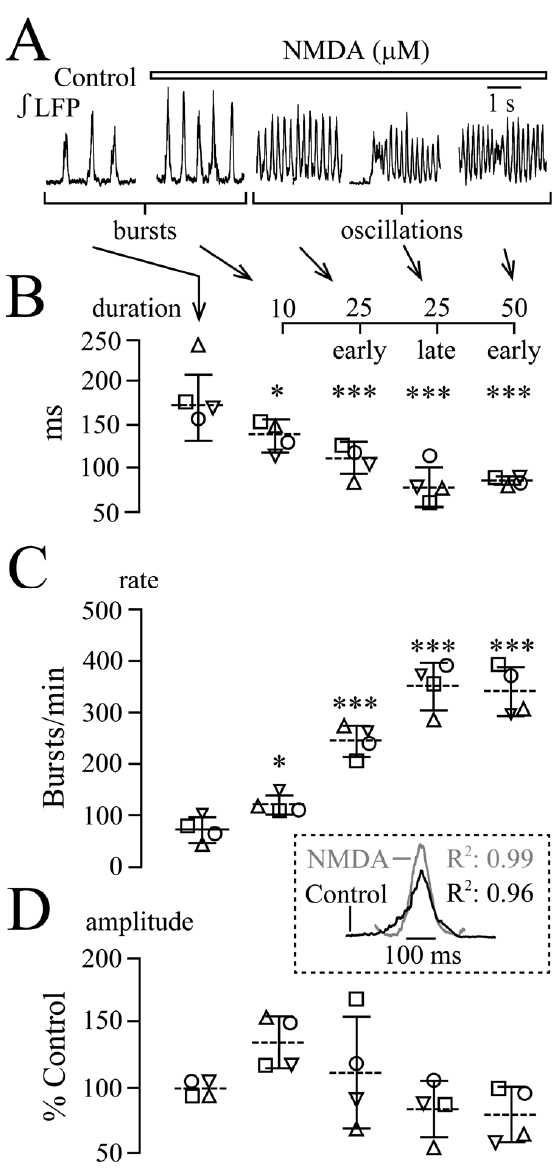
panels). Dashed-line box indicates the time period for which oscillations are displayed at higher time resolution in ( E ) showing on raw trace smaller amplitude integrated signals are due to tonic activity. Right panels in ( D ) also show augmented decline of amplitude, duration and regularity of oscillation trains at 2 min, compared to effects in 25 µ M at ~5 min. ( F ) At 3 min of the experiment in ( C – E ), oscillation trains were notably attenuated (left), whereas only a spike-shaped rhythm remained at 4 min and no activity was seen at 5 min.